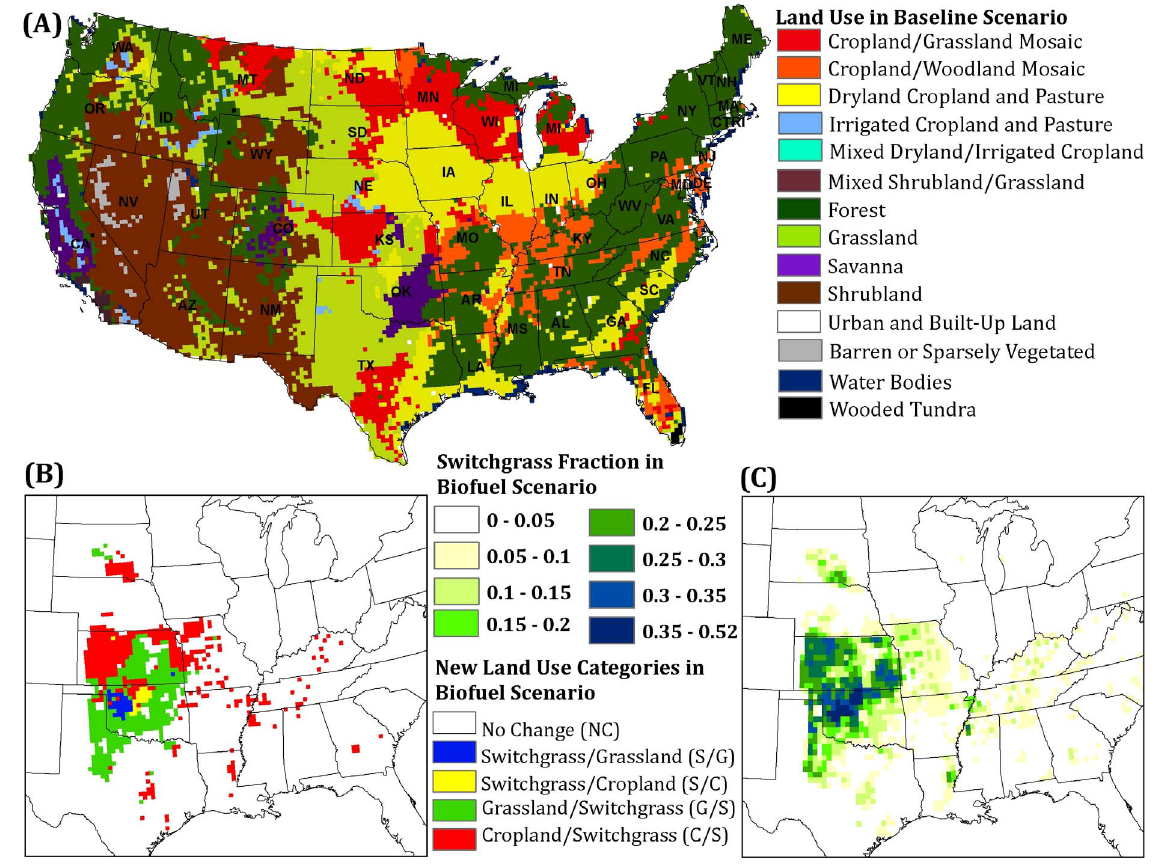
Figure 1. Default land use categories in the WRF model (A); new land use categories defined for the biofuel scenario (B); and fraction of land use that is switchgrass in the biofuel scenario (C).